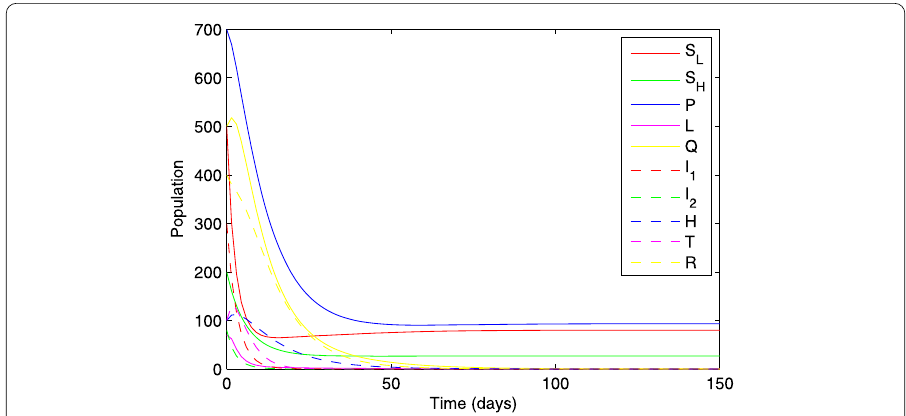
Figure 3 The population approaches DFE when R C = 0.238